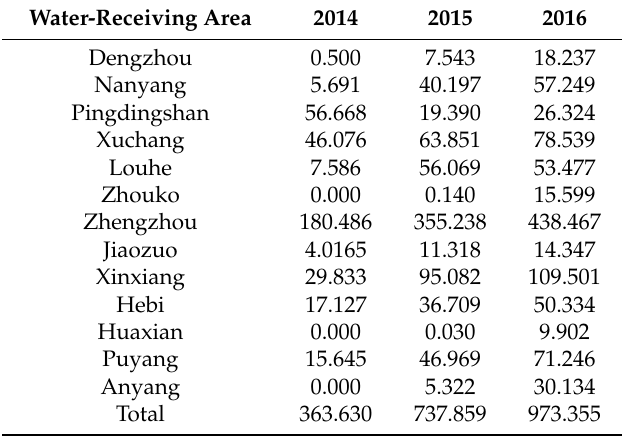
Table 1. Water supply pattern in each water-receiving city in 2014–2016 (10 6 m 3 ).